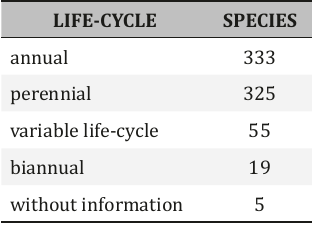
Types of life-cycle and number of species of alien flora in Chile.